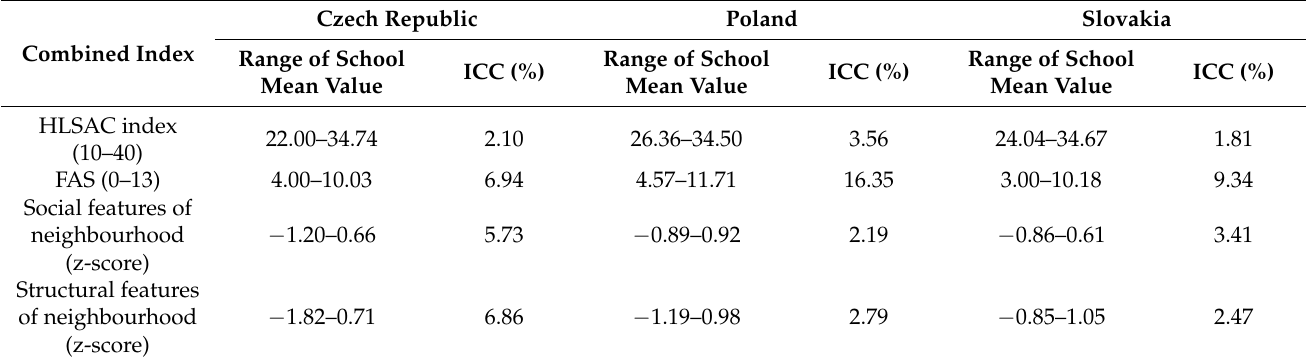
Table 5. Differences between schools in terms of HLSAC level and social indices.